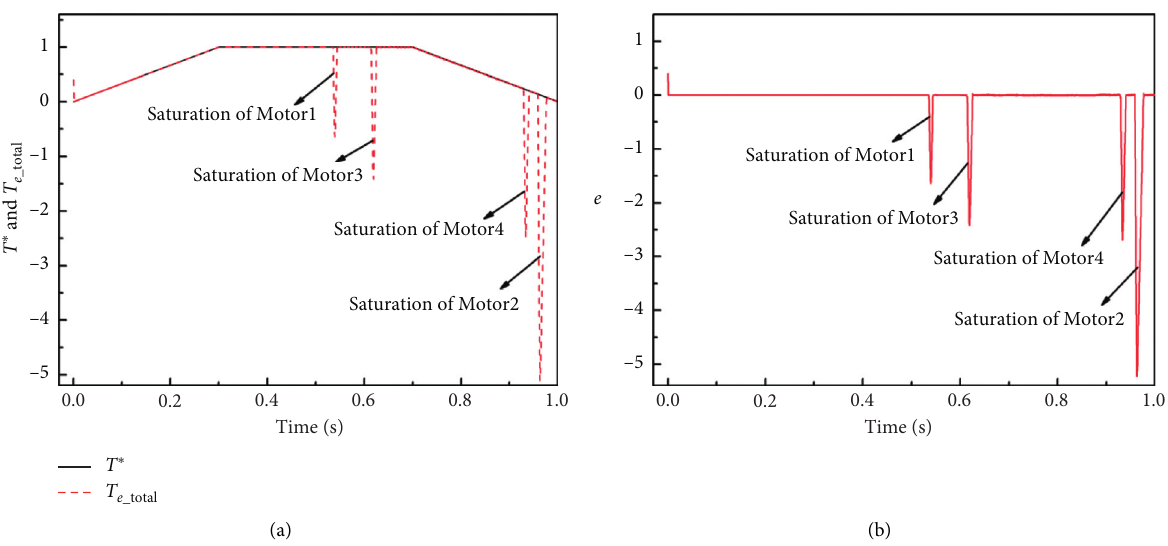
Figure 4: The TACTC without AW: (a) the tracking curve of total traction torque amount, (b) the tracking error curve of total traction torque amount.